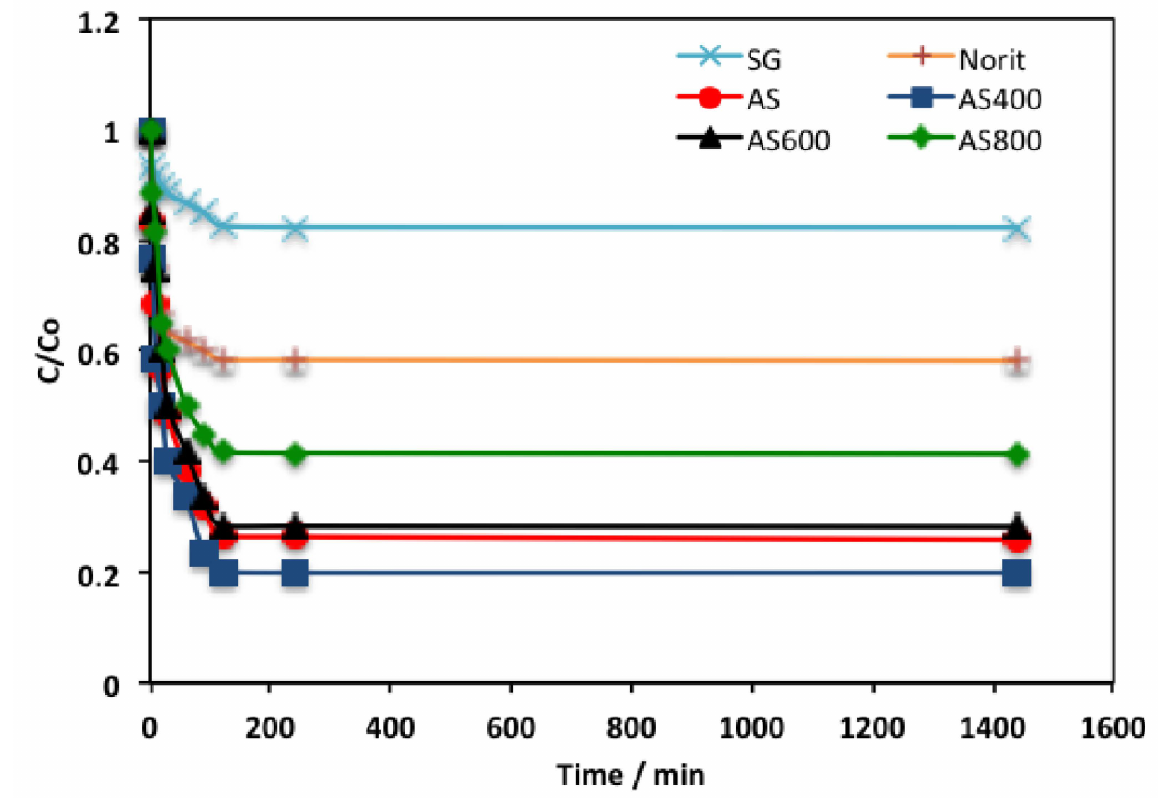
Figure 6. Contact time profile on the phenol uptake using different